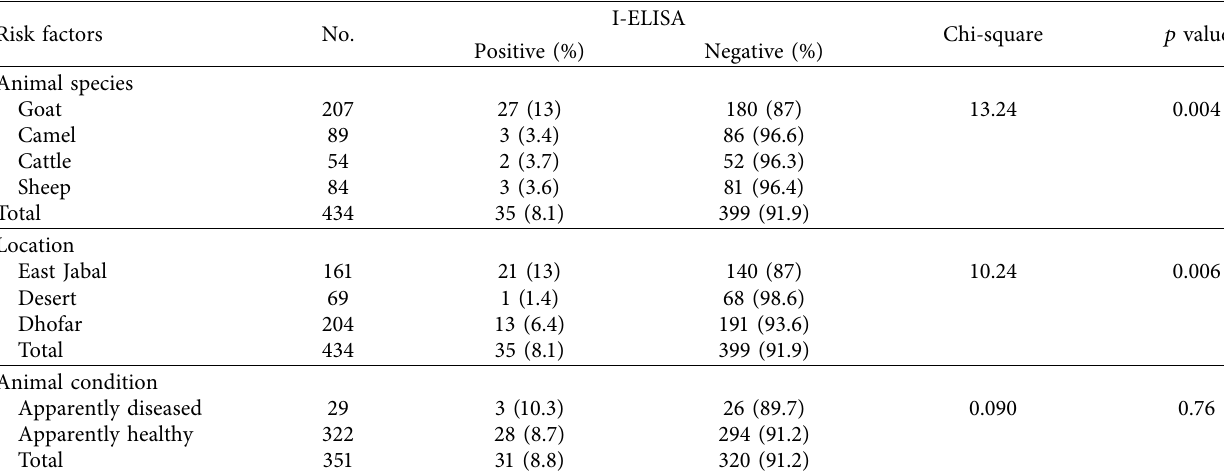
Table 2: Binary logistic regression of hypothesized risk factors associated with Brucella seroprevalence using the ELISA. Risk factors β